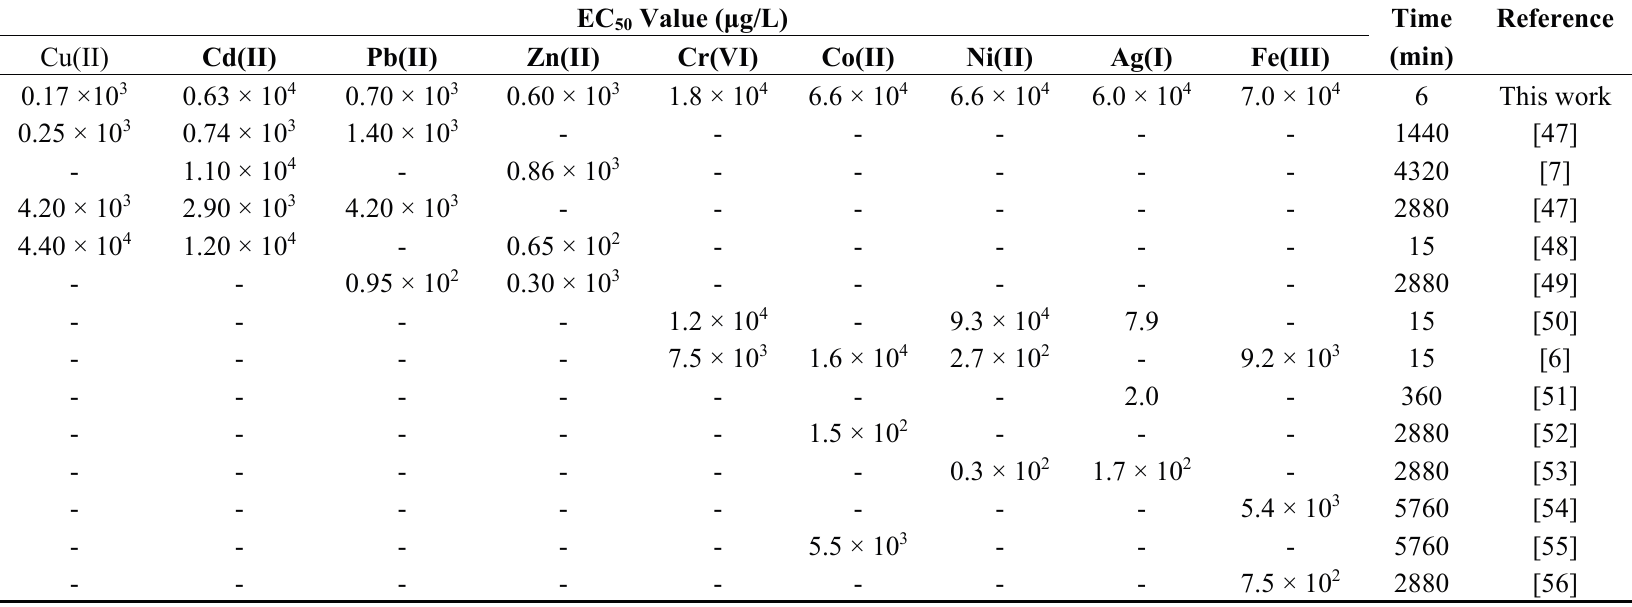
Table 4. Comparison of EC 50 values for Cu(II), Cd(II), Pb(II), Zn(II), Cr(VI), Co(II), Ni(II), Ag(I) and Fe(III) toxicities obtained from the developed luminescent bacteria biosensor based on alginate microspheres with the EC 50 values reported in the